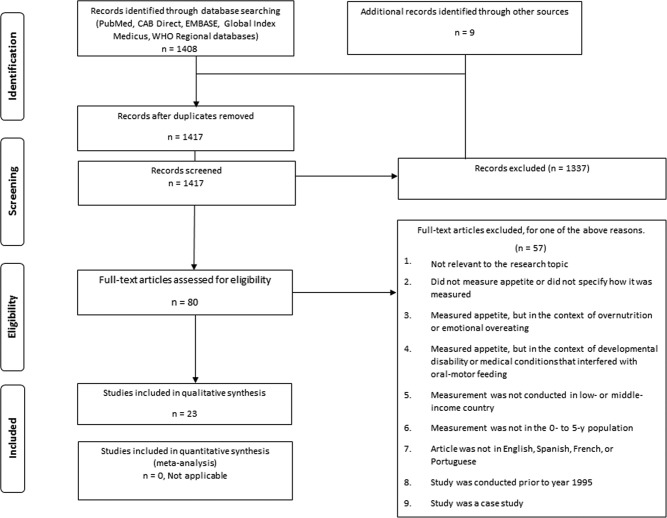
PRISMA flowchart of article inclusion and exclusion criteria based on study protocol. PRISMA, Preferred Reporting Items for Systematic Reviews and Meta-Analyses.